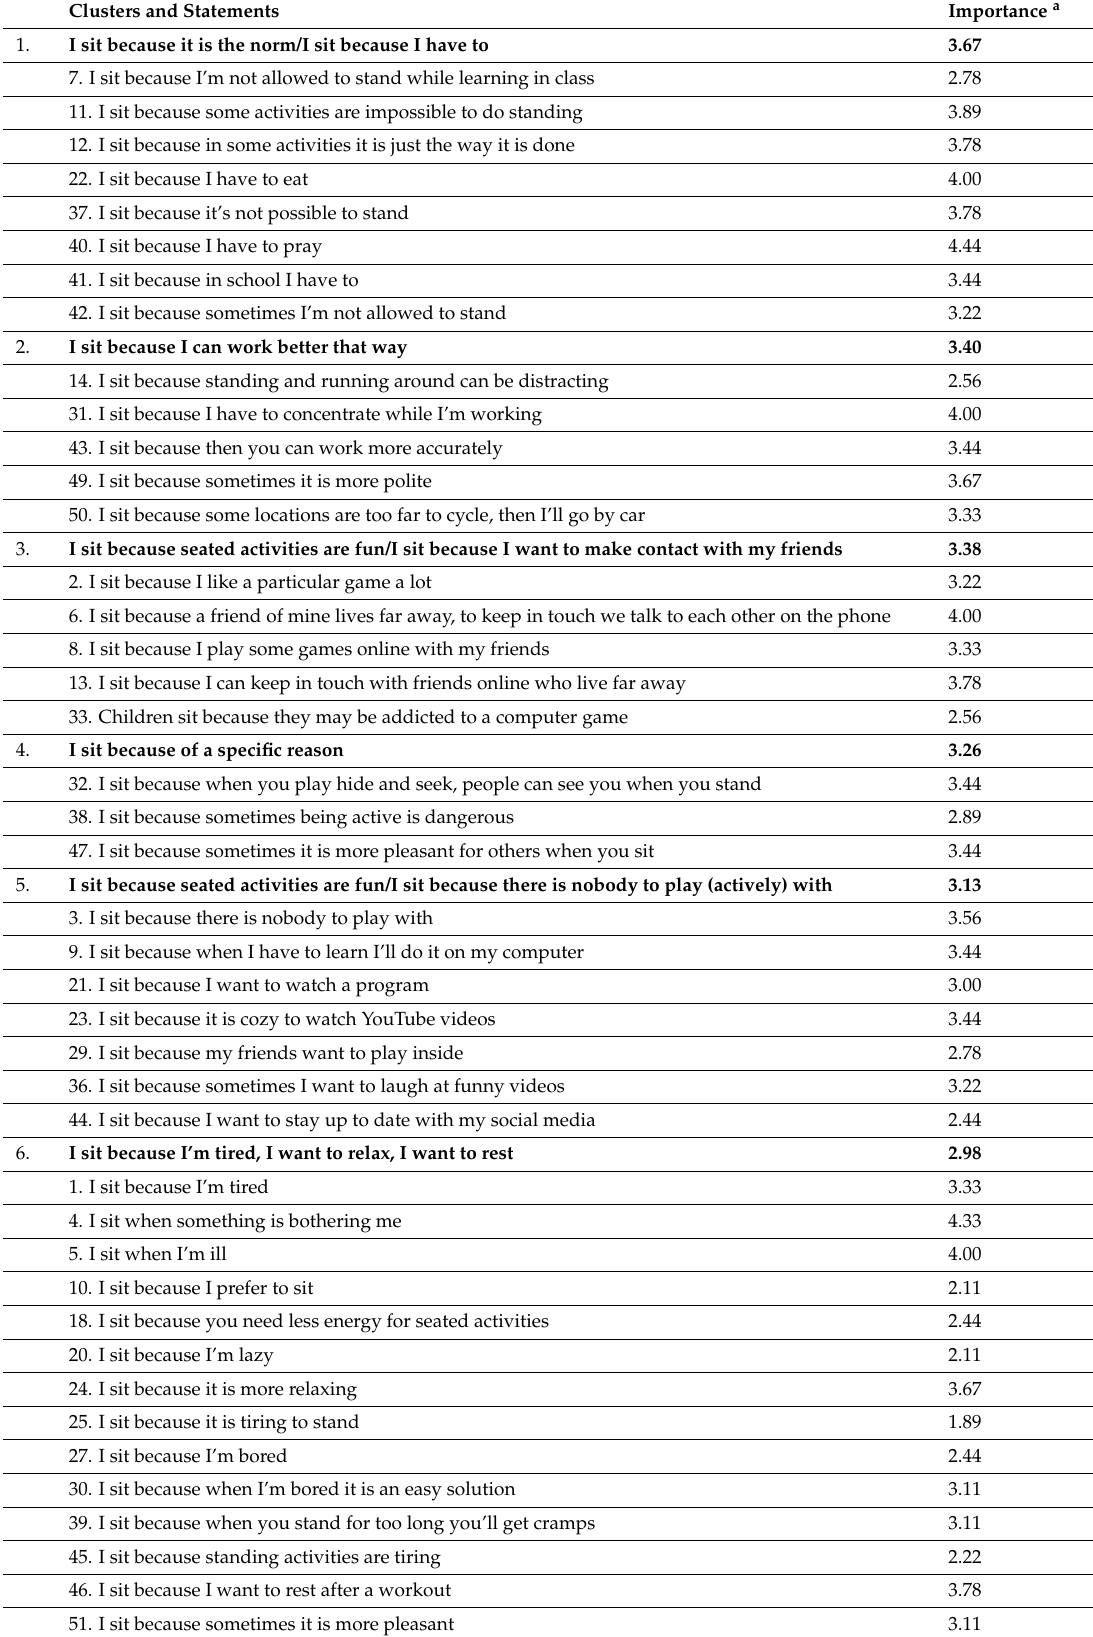
Table A4. Clusters, statements and importance ratings of children (school